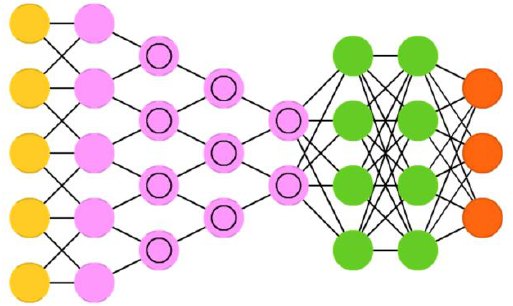
Figure 3. Scheme of the typical